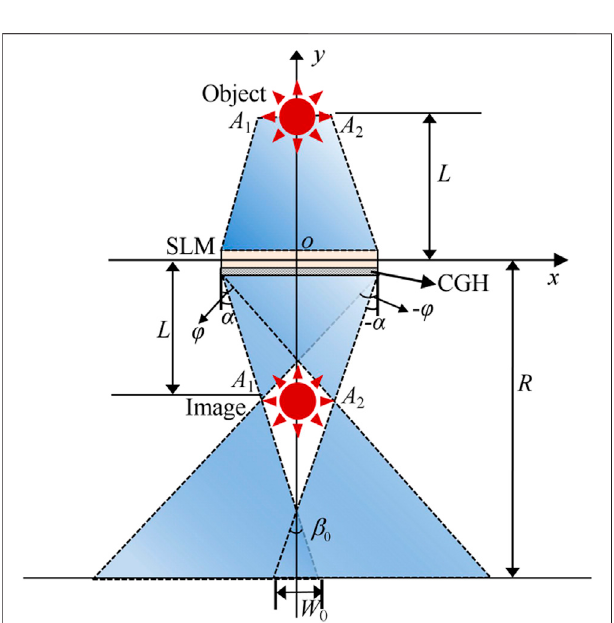
FIGURE 2 | Light distribution of the reconstructed